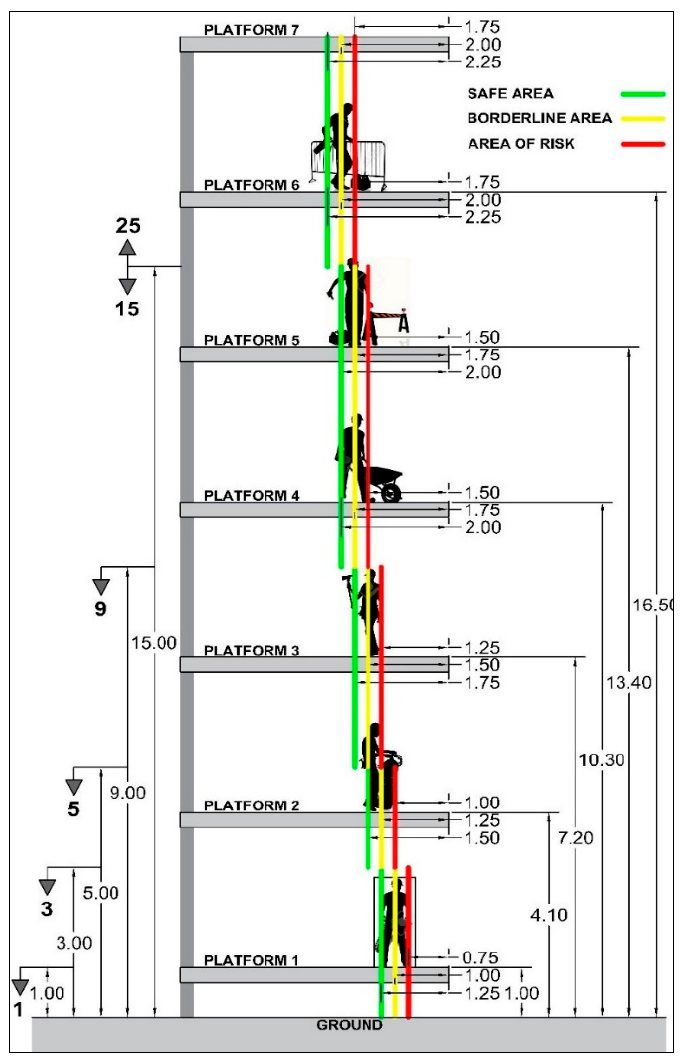
Figure 7. Diagram showing borderline risk.